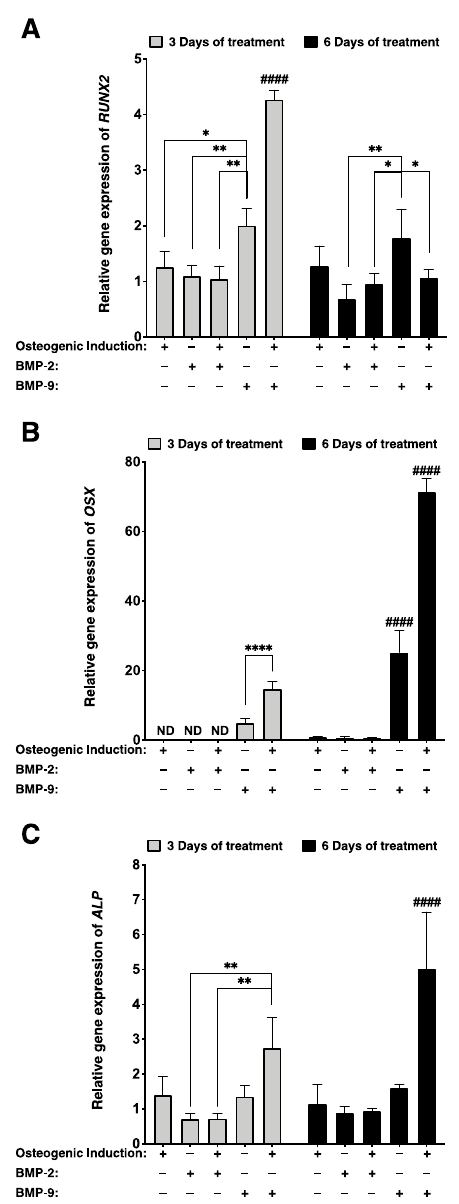
Figure 1. Robust osteogenic gene expression profiles from osteogenically induced hASCs when treated with rhBMP-9 in 2D cell culture. ( A – C ) Relative gene expression of ( A ) runt-related transcription factor 2 ( RUNX2 ), ( B ) osterix ( OSX ), and ( C ) alkaline phosphatase ( ALP ) measured by RT-qPCR on osteogenically induced and non-induced hASCs treated with 1 nM of rhBMP-2 or rhBMP-9 for three or six days. (Two-way ANOVA with a Bonferroni’s multiple comparison post-hoc test; significant differences between two conditions per time point: * p < 0.05, ** p < 0.01, **** p < 0.0001 and significant difference between one condition and all other conditions: #### p < 0.0001).